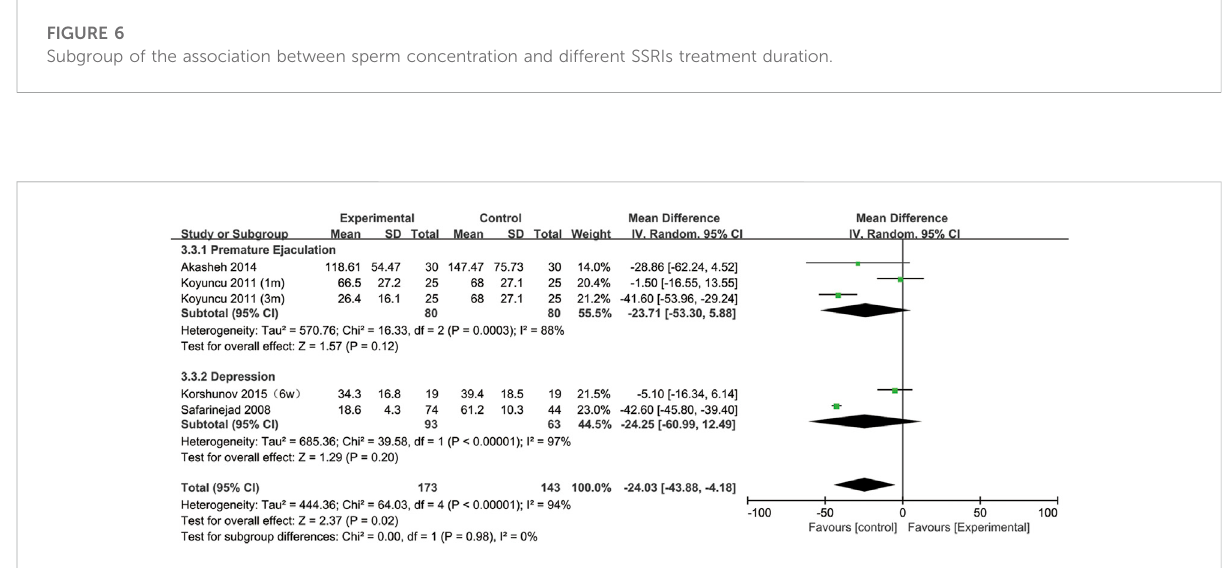
Subgroup of the association between sperm concentration and different basic disease.